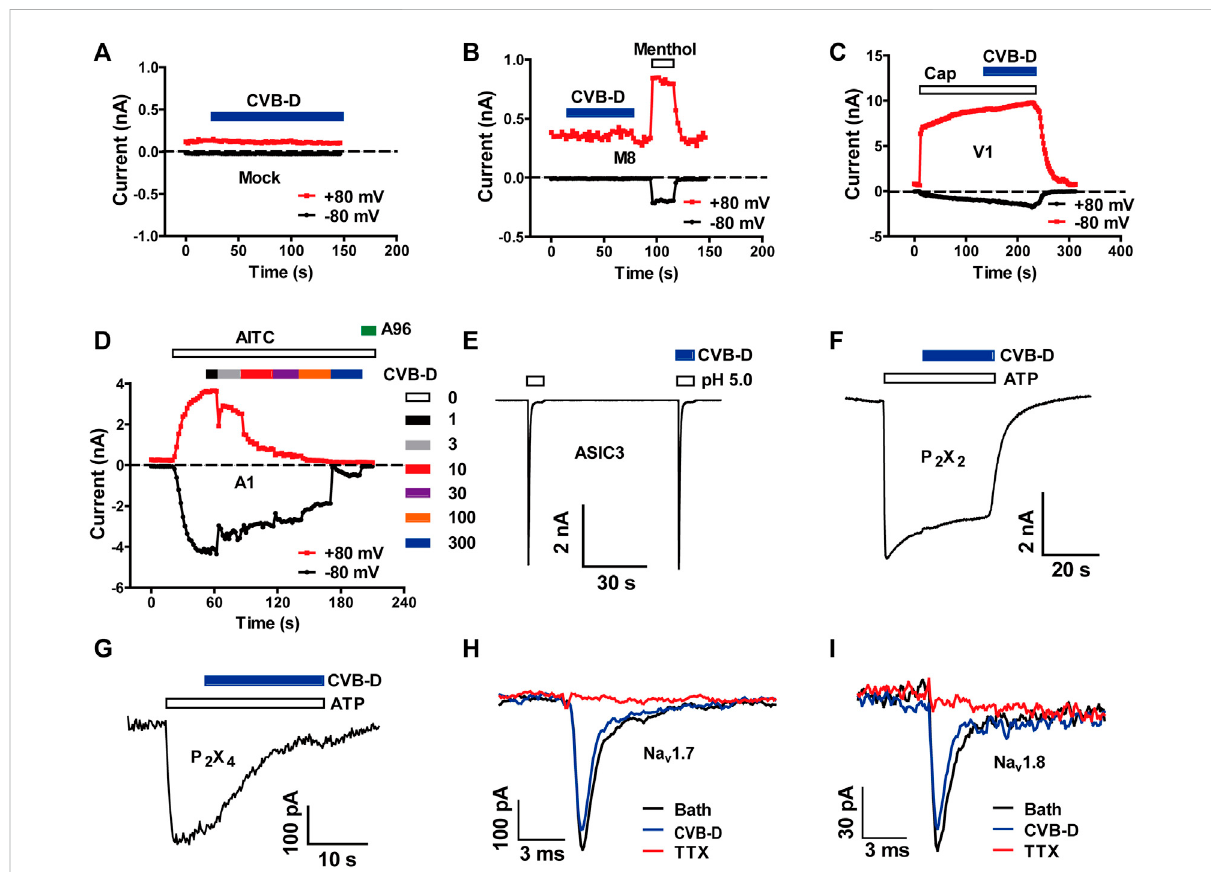
FIGURE 2 EffectofCVB-Donrecombinantnociceptiveionchannels. (A – G) Representativewhole-cellcurrentsinmocktransfectedHEK293Tcells (A) or cellsexpressingTRPM8 (B) ,TRPV1 (C) ,TRPA1 (D) ,ASIC3 (E) ,P 2 X 2 (F) andP 2 X 4 (G) inresponseto500 μ Mmethol (B) ,1 μ Mcapsaicin (C) ,100 μ MAITC (D) ,extracellularsolutionwithanacidicpHof5.0 (E) ,and100 μ MATP (F,G) intheabsenceorpresenceof30 μ MCVB-D(n=4foreachchannel). (H,I) Representative whole-cell currents in HEK 293T cells expressing Na v 1.7 and Na v 1.8 in the absence or presence of 30 μ M